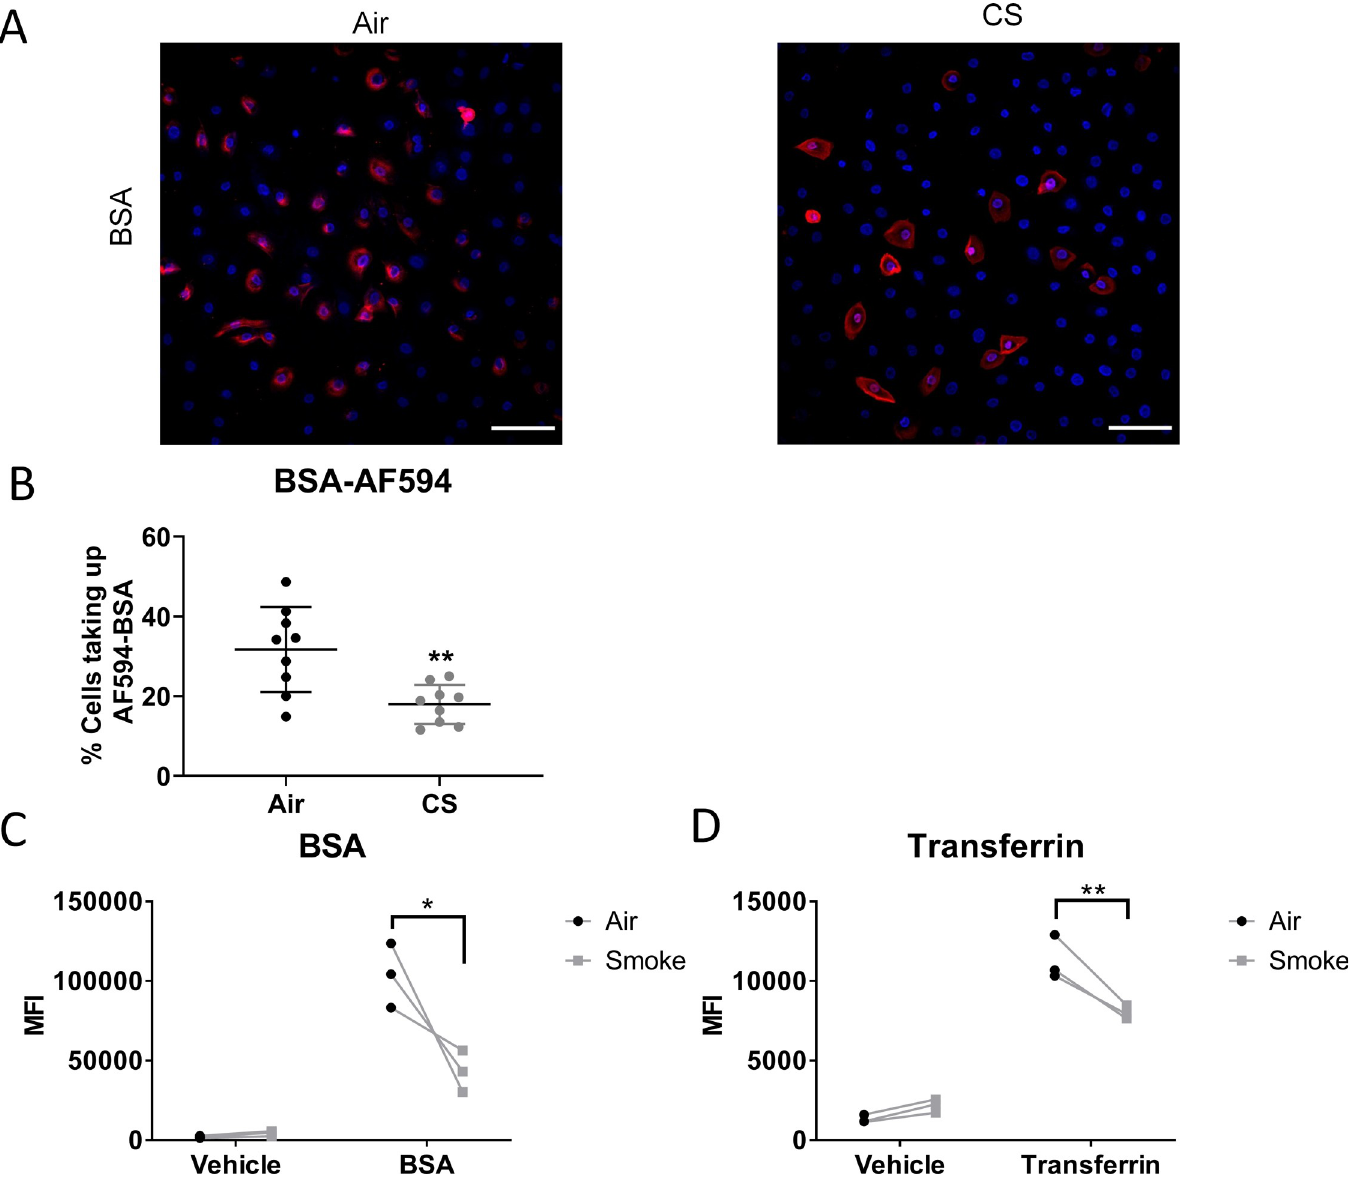
Fig 3. Cigarette smoke decreases clathrin mediated endocytosis. Primary human SAEC were exposed to either air or cigarette smoke for 60 minutes at the air-liquid interface. Following exposure cells were treated with AF594-labeled BSA (pictures in A, B) or AF488-labeled BSA (flow cytometry, C) (50 μ g/mL) or AF488-labeled transferrin (Tfn, 125 μ g/mL) as described in the materials and methods. (A) Photographs of air and smoke-exposed cells treated with AF594-BSA. Similar results were seen in 3 strains of SAEC tested. (B) AF594-BSA labeled cells were quantified as described in the Methods, using 3 high power fields per culture and three replicate cultures of one SAEC cell strain. Uptake of (C) AF488-BSA and (D) AF488-Tfn fluorescence was determined by flow cytometry. Each pair of points represents an SAEC strain from a different donor. � p < 0.05 ��� p < 0.001 by two way ANOVA with Sidak correction.